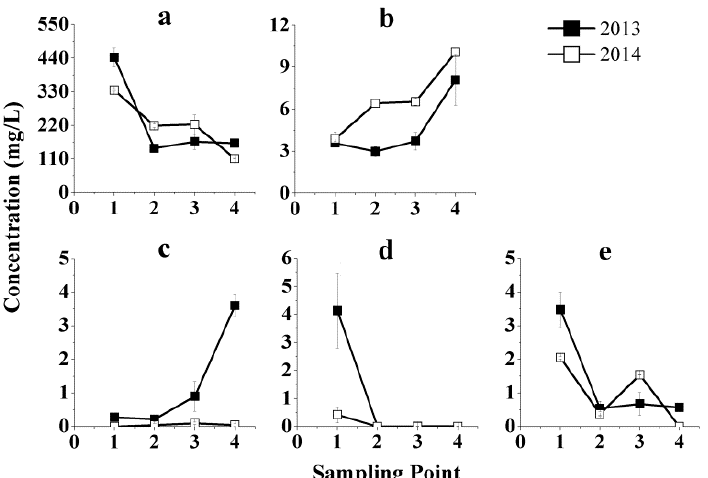
Figure 2. Phenolic evolution during vinification of Beibinghong red ice wine from two vintages, 2013 and 2014. ( a ) Evolution of anthocyanins during vinification; ( b ) Evolution of hydroxybenzoic acids during vinification; ( c ) Evolution of hydroxycinnamic acids during vinification; ( d ) Evolution of flavan-3-ols during vinification; ( e ) Evolution of flavonols during vinification.